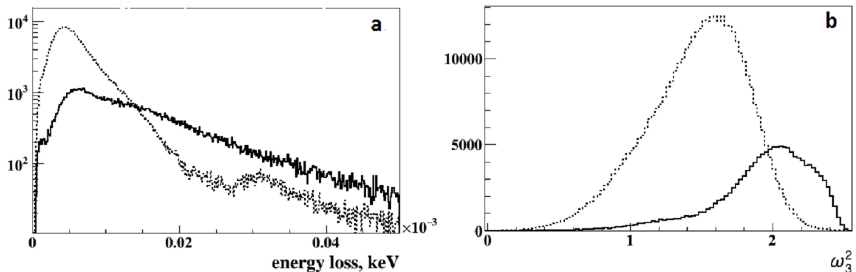
Figure 1. General view of the CBM